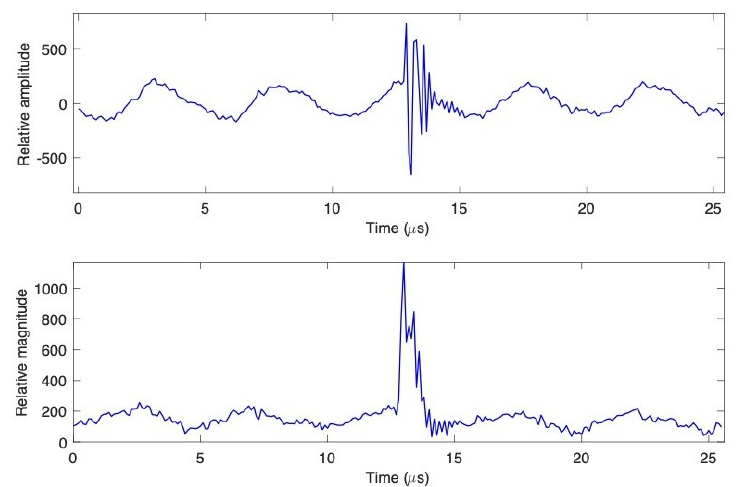
Figure 10. The received signal during the measurement experiments: the plots on the top row is the real part of the signal, and the plots on the bottom row is the magnitude of the received